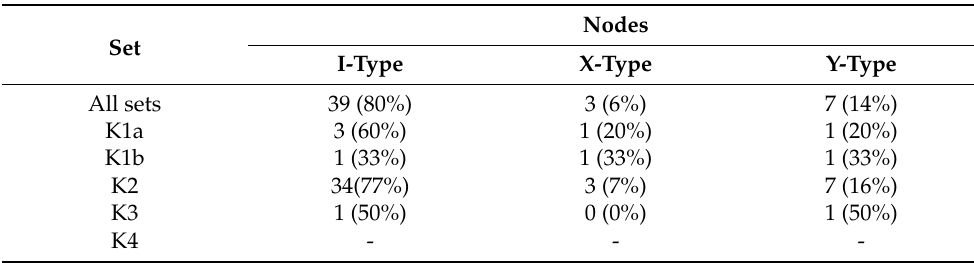
Table 4. Fracture node statistics retrieved from the topological analysis of the 2D fracture traces mapped onto the top of Lastoni di Formin Heiligkreuz